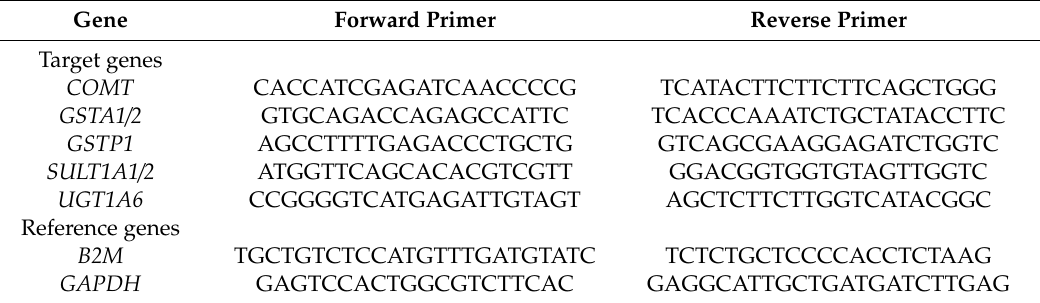
Table 1. List of the primers used for RT-qPCR analysis of the selected genes.